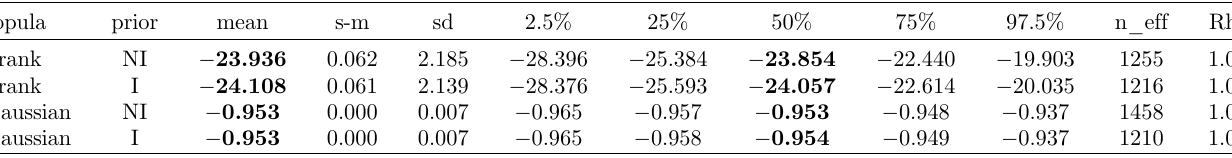
factor on split chains (at convergence, Rhat = 1). In bold letter the Bayesian estimates of h for Frank and q for Gaussian copula, by quadratic loss function on left, by multi linear loss function on right. Non-Informative (NI) prior on top and Informative (I) prior on